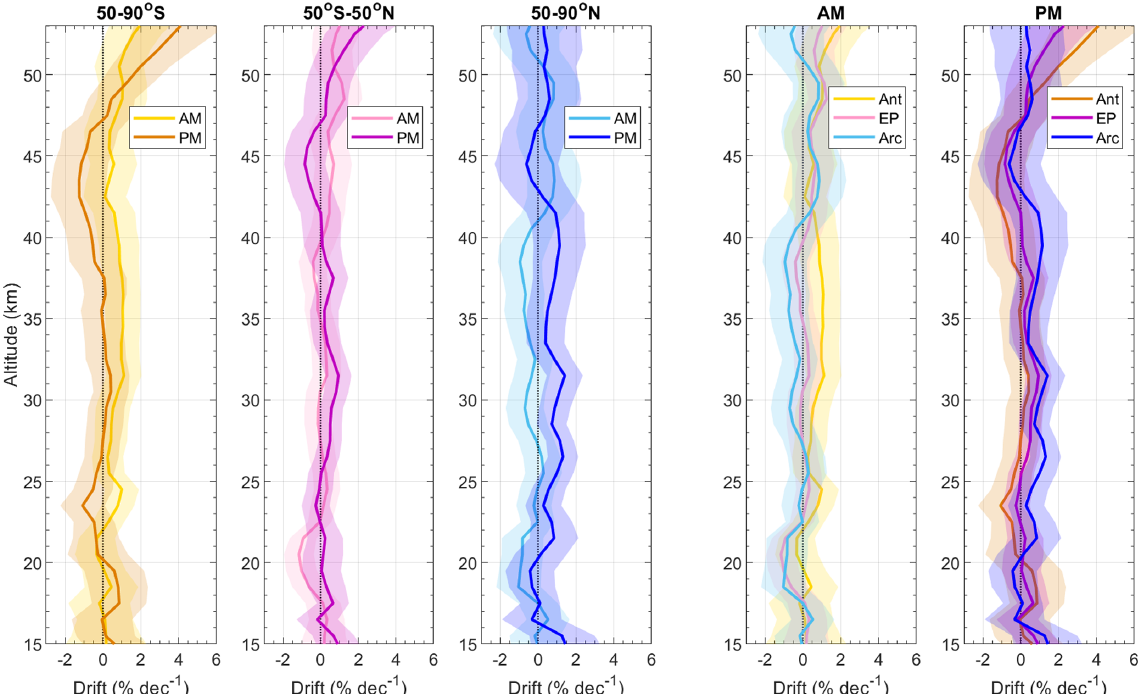
Figure 11. Weighted-average ACE-FTS v4.1 drift profiles for comparisons in Antarctic (Ant), extra-polar (EP), and Arctic (Arc) latitude bands and separated by AM and PM local times. Shaded regions (semitransparent) represent 99% confidence bounds.